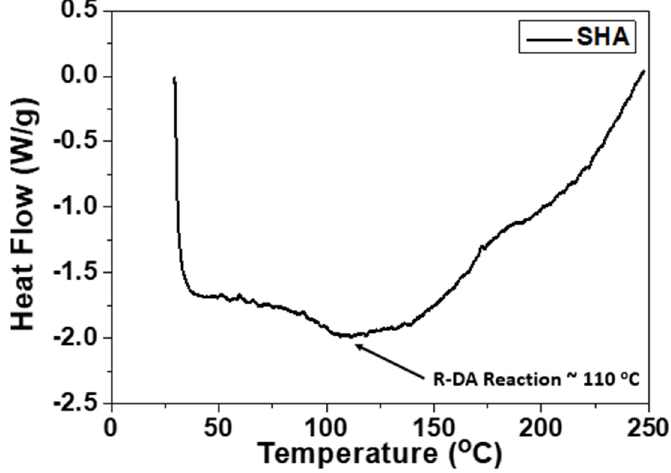
Figure 11. Differential scanning calorimetry (DSC) curve for the Diels–Alder (DA) mechanism-based SHA, utilized for the needs of the current study.